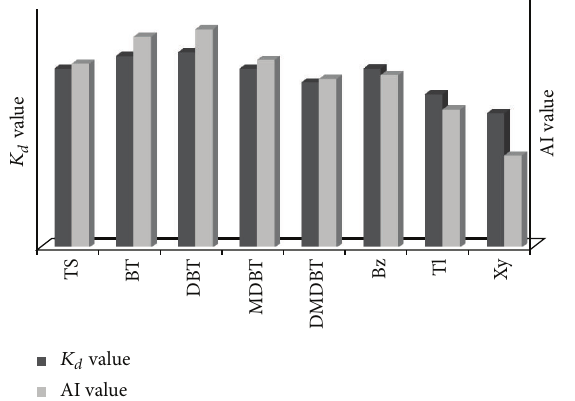
Figure 6: Comparison of DBE value and desulphurization partition coefficient ( 𝐾 𝑑 value) of anions solely with